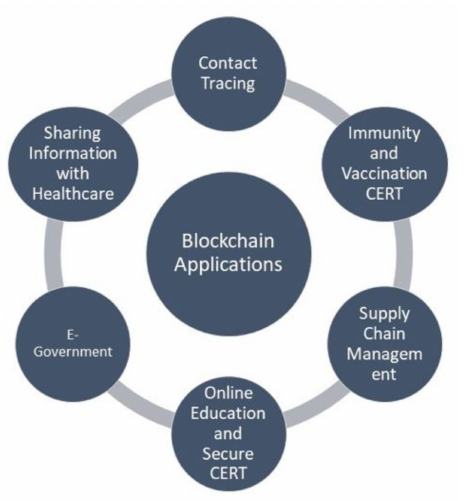
Figure 4. Contributions of blockchain technology during the COVID-19